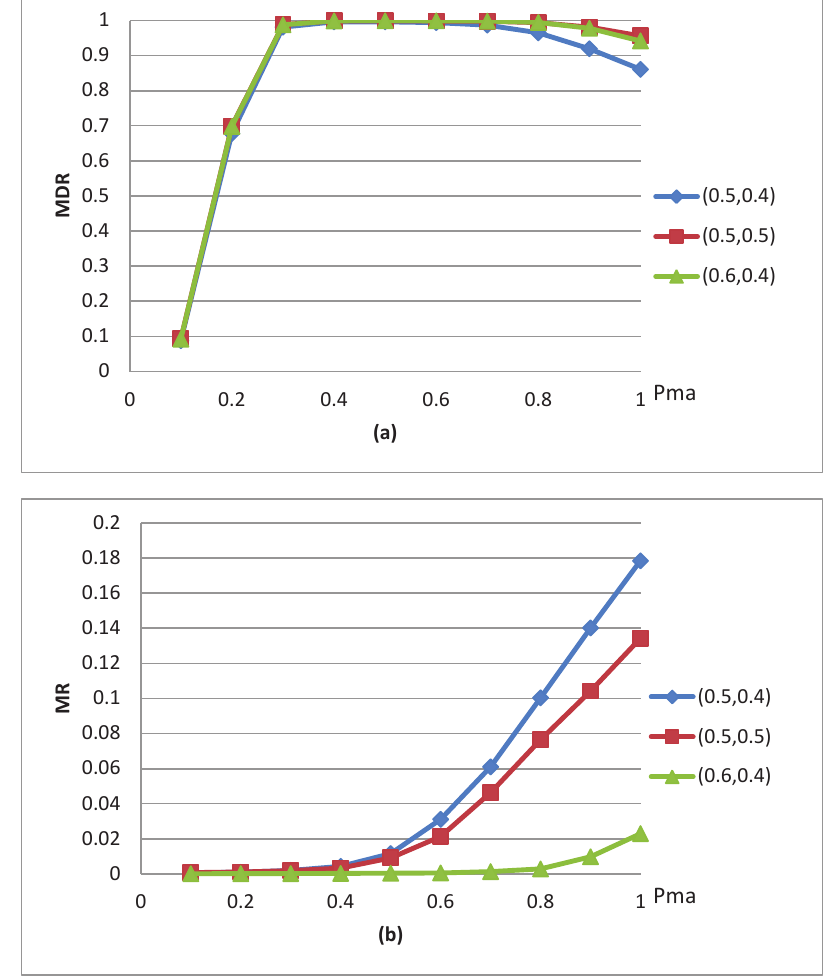
when p = 0.1, p = 0.2 and p ma t m